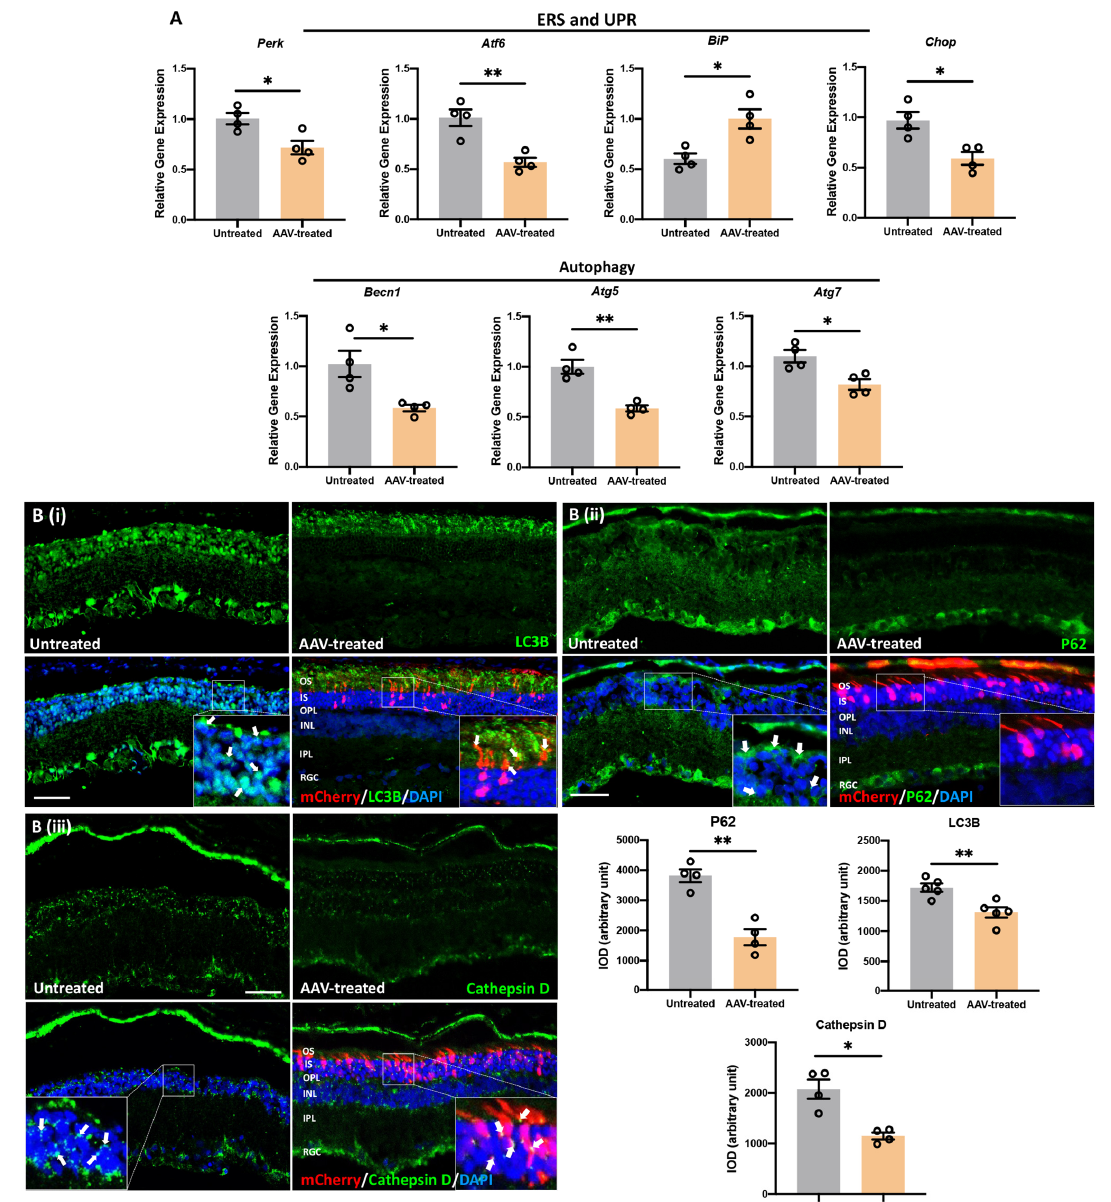
Figure 7. m- Rho P23H ablation reduced retinal autophagy via suppressing UPR and ERS. ( A ) qPCR of Perk, BiP, Atf6, Chop (marker genes of UPR and ERS) and Becn1, Atg5, Atg7 (marker genes of autophagy). In AAV-treated retinas, only the BiP functional transcripts showed significantly increased expression, whereas mRNA levels of remaining genes associated with UPR/ERS and autophagy decreased significantly compared to untreated retina. ( B ) Immunofluorescence of ( i ) autophagosomes (LCB3), ( ii ) autophagy receptors (P62/SQSTM1) and ( iii ) lysosomes (cathepsin D) in AAV-treated vs. untreated retinas. LC3B, P62 and cathepsin-D immunoreactivity was decreased significantly in AAV-treated retina compared to the untreated retina. LC3B expression was restricted to the outer segments of the PR layer in AAV-treated retina. By contrast, untreated retina showed punctate expression of LC3B, P62, and cathepsin D in the INL. Significantly reduced expression of P62 and cathepsin D was observed in RPE, ONL, and INL of AAV-treated retina. Scale bar, 100 µ m. Nuclei were stained with DAPI. INL, inner nuclear layer; IS, inner segment; ONL, outer nuclear layer; OS, outer segment; PR, photoreceptor; RGC, retinal ganglionic cell. Data represent the mean ± SEM ( n = 4). * p ≤ 0.05, ** p ≤